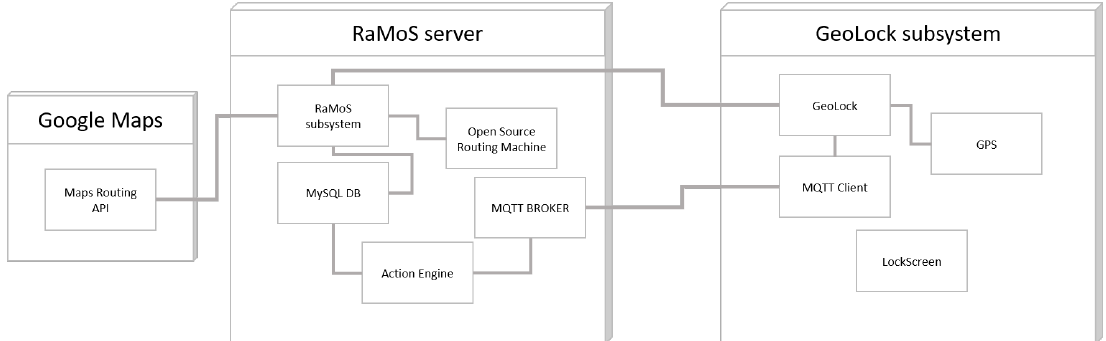
Figure 1. Overall summarized system architecture of our